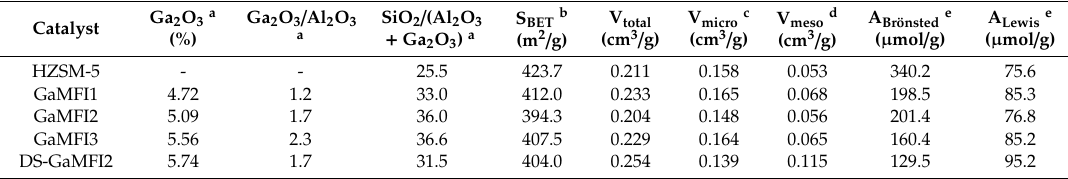
Table 1. Characterizations of the HZSM-5 and Ga-containing MFI